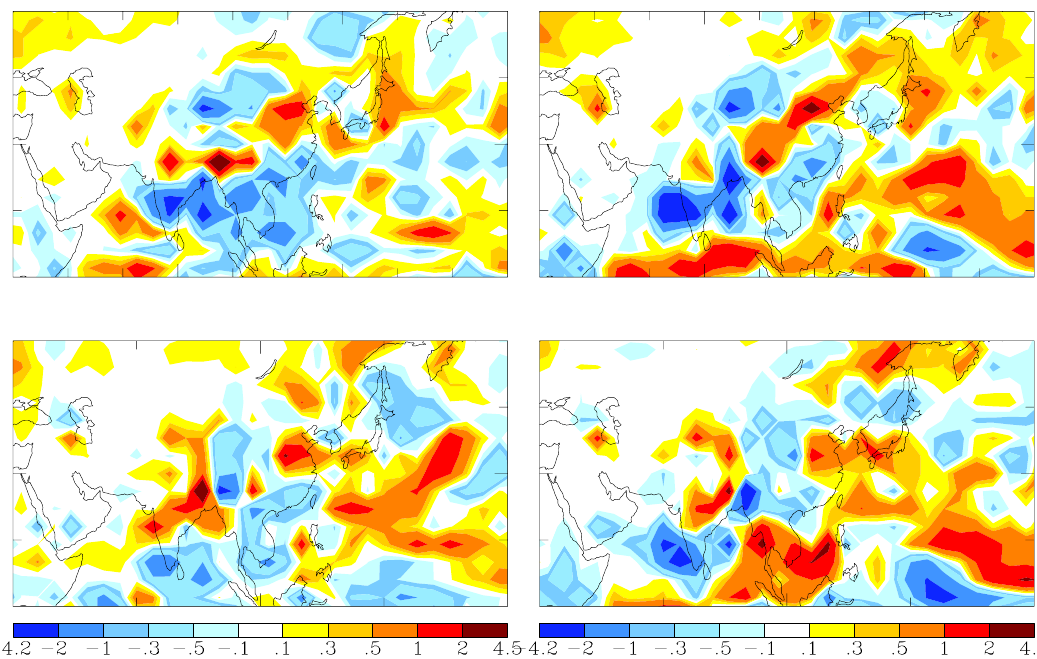
Fig. 10. Average difference in summer (June to August) precipitation (in mm/d) for differences in emissions between 2000 and 1990 without (left panel) and with (right panel) the climate influence for the Beig (top panels) and Bond (bottom panels) emissions. Simulations include the direct and indirect effects and changes in snow/ice albedo due to black carbon deposition on snow/ice surfaces.